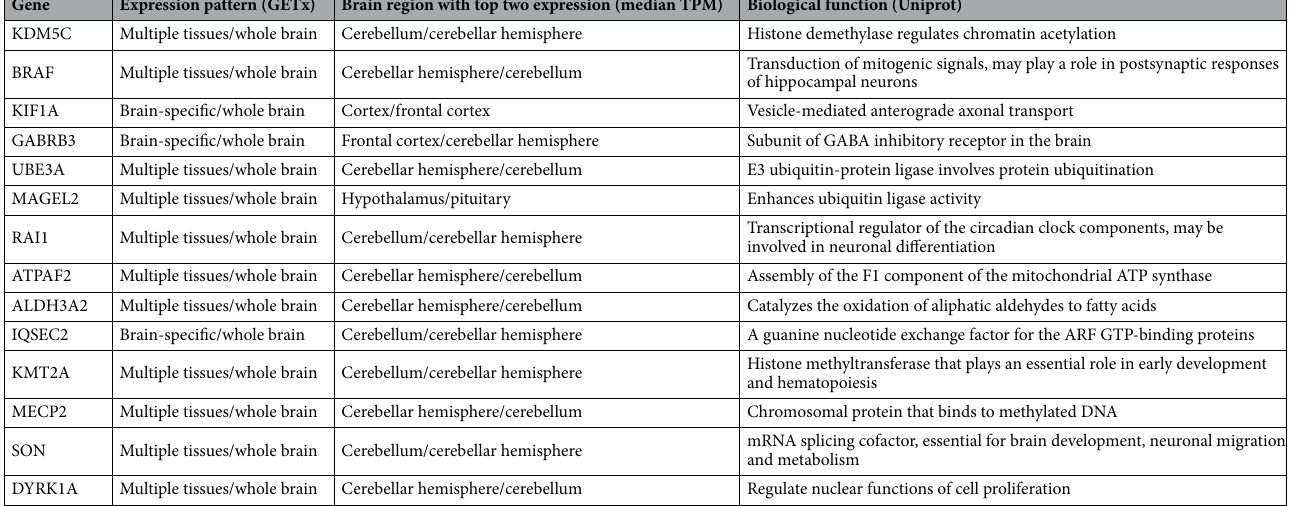
Table 4. Tissue expression pattern and biological function in ASD-DD/ID associated genes. GABA γ-Aminobutyric acid, GETx Genotype-tissue expression protal (www. getxp ortal. org), TPM transcripts per kilobase million, UniProt database (www. unipr ot.